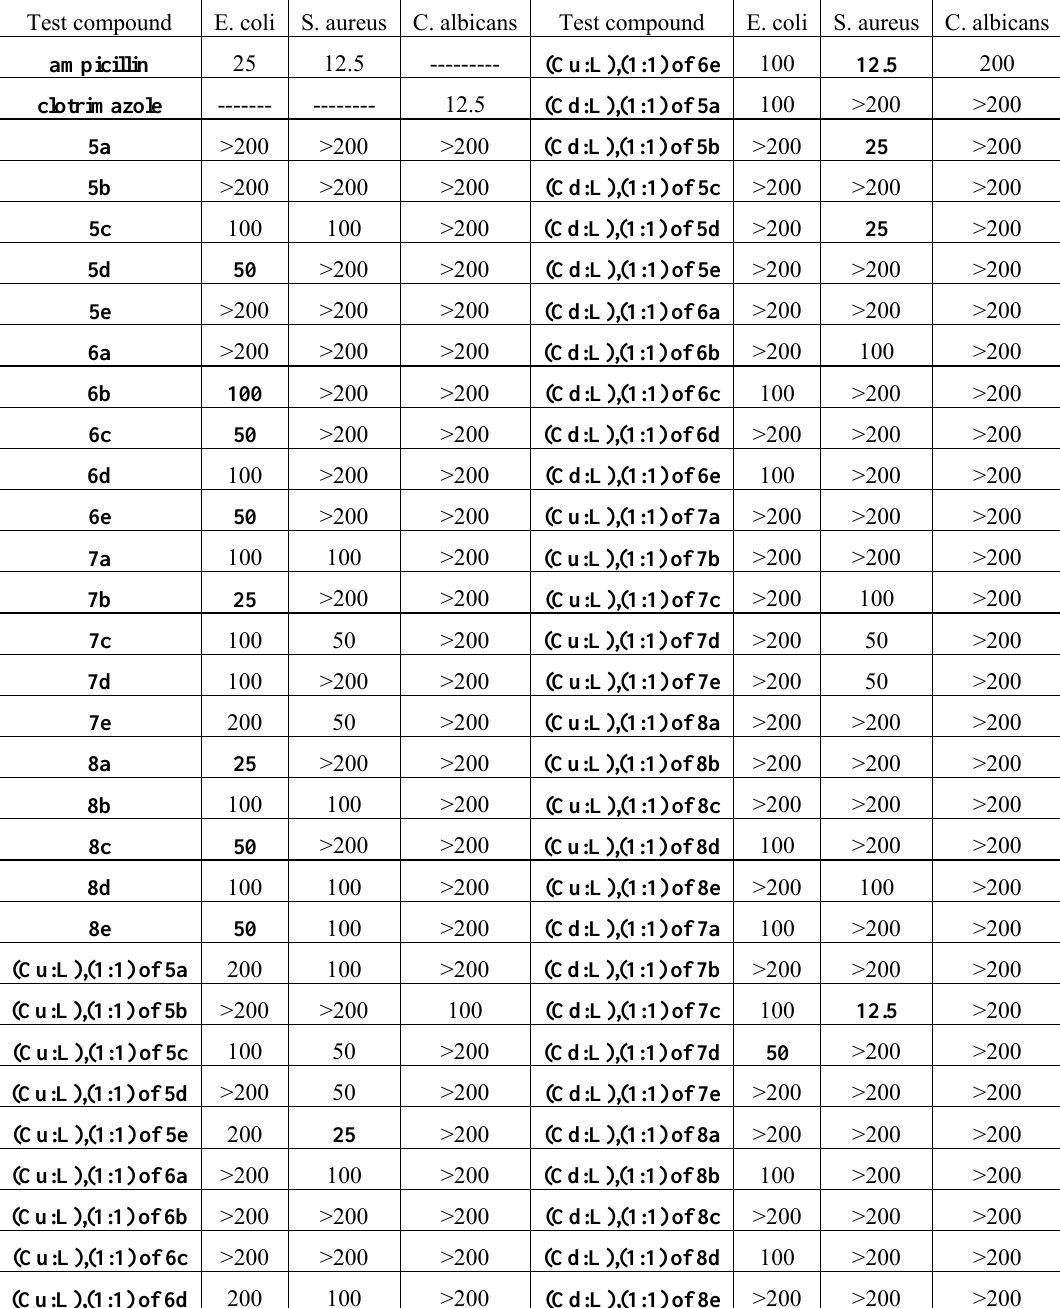
Table 3 . Minimal inhibitory concentration (MIC) of test compounds in µg/mL. Test